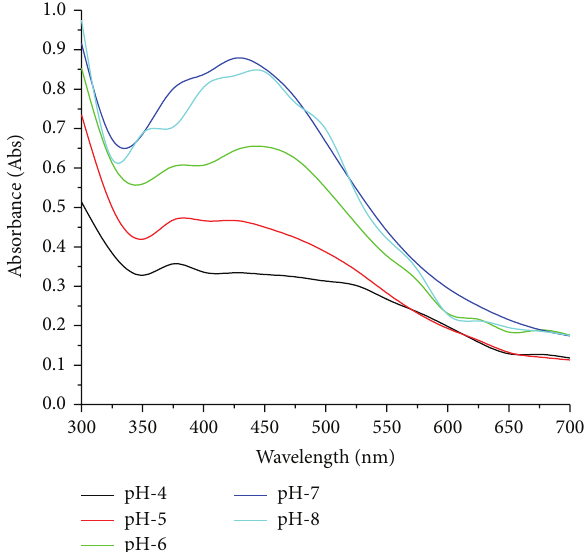
Figure 5: UV-visible absorption spectra of biosynthesized AgNps at different